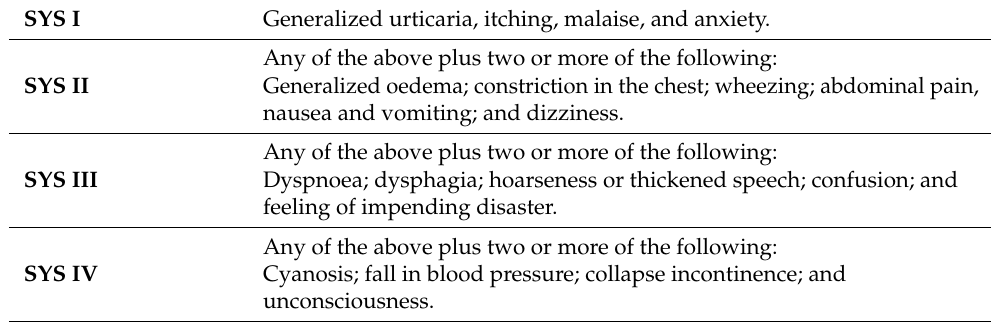
Table 3. Classification of anaphylactic reaction after insect stings according to Mueller [23].